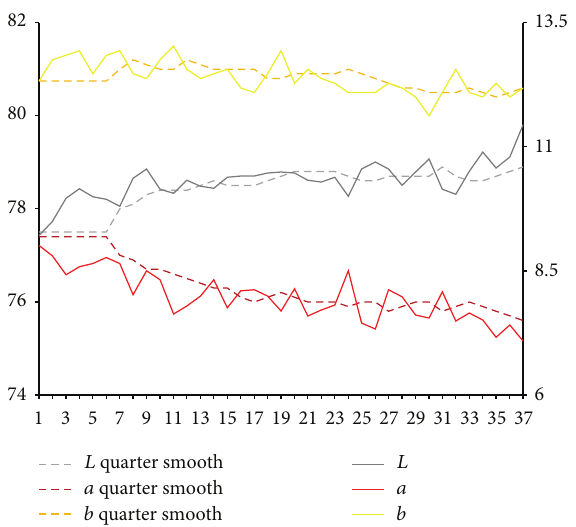
Figure 11: Lab value changing trend of underjaw.